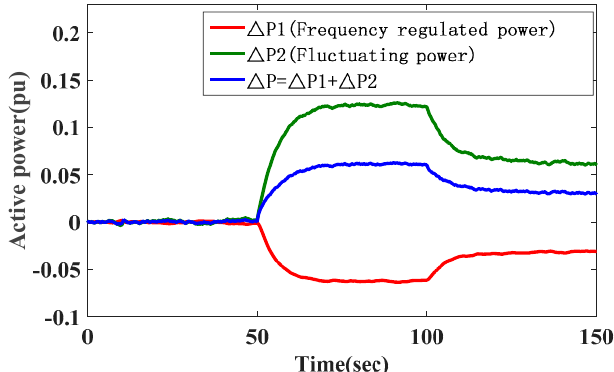
Figure 19. Active power response when the wind speed change suddenly.